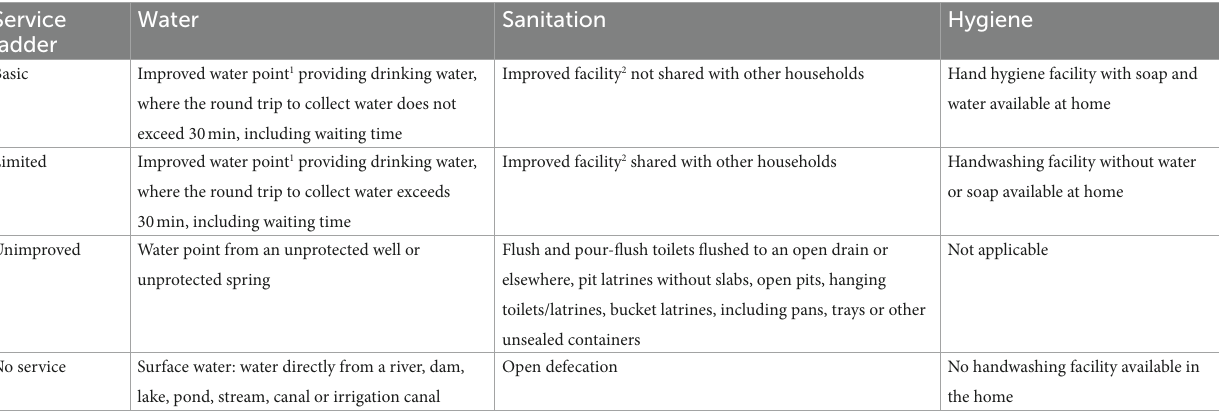
TABLE 2 WHO/UNICEF JMP scale for WASH